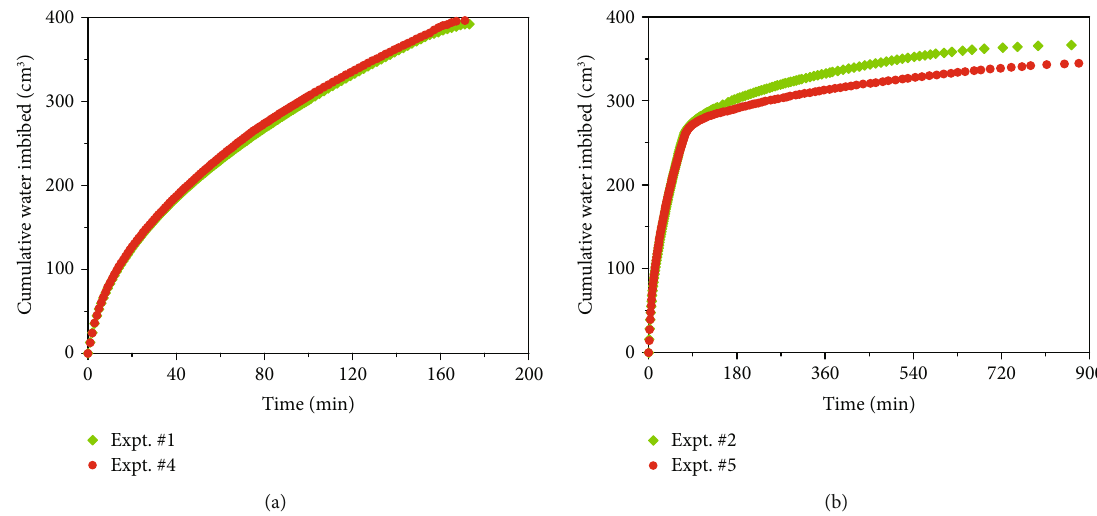
Figure 7: The comparisons of cumulative water imbibed between (a) Expt. #1 and Expt. #4, as well as between (b) Expt. #2 and Expt.